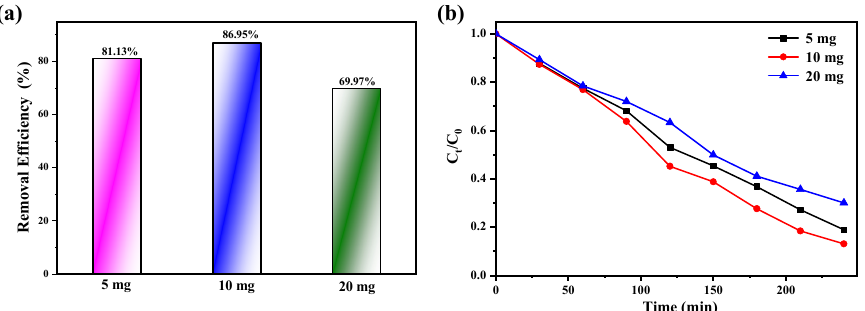
Figure 9. ( a ) Effect of catalyst 1 dosage, ( b ) Degradation rate of compound 1 to ciprofloxacin under different doses.